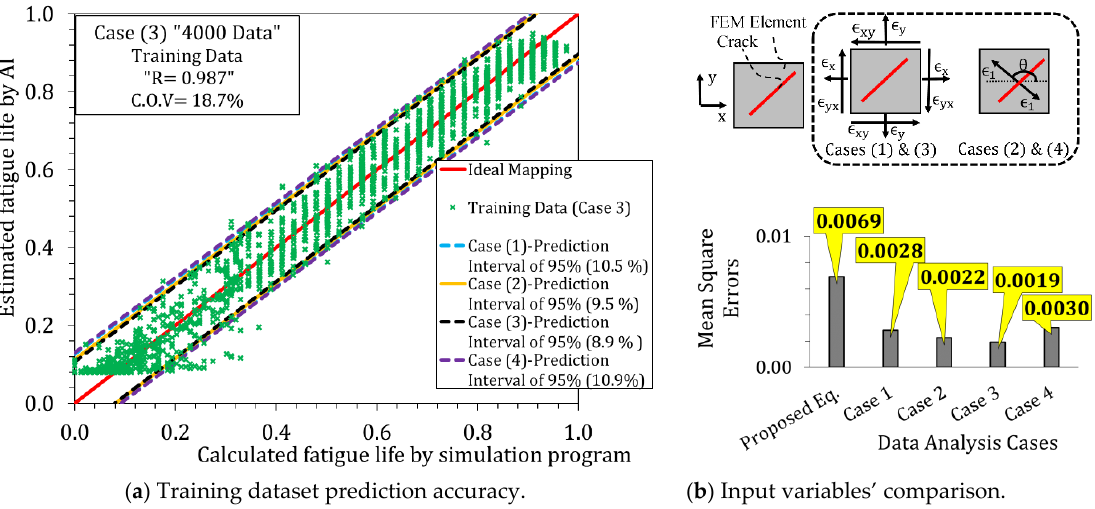
Figure 14. Relationship between the fatigue life of “multiscale simulation program” & “ANN” for the training dataset.